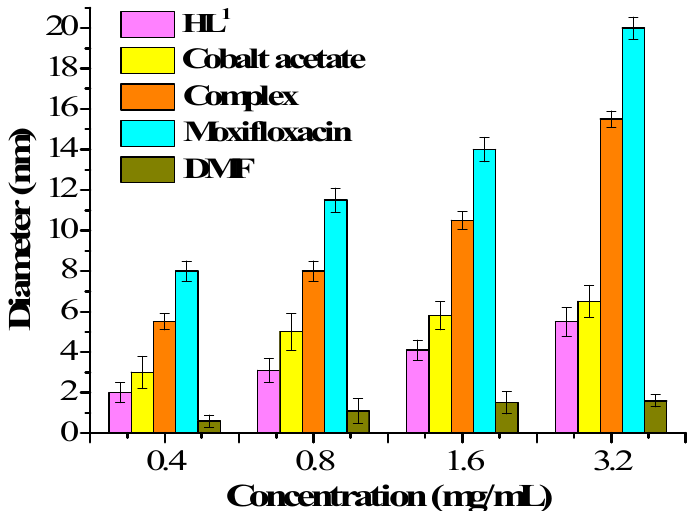
Figure 10. A histogram of the inhibition zone diameter of Escherichia coli at different concentrations of different samples.